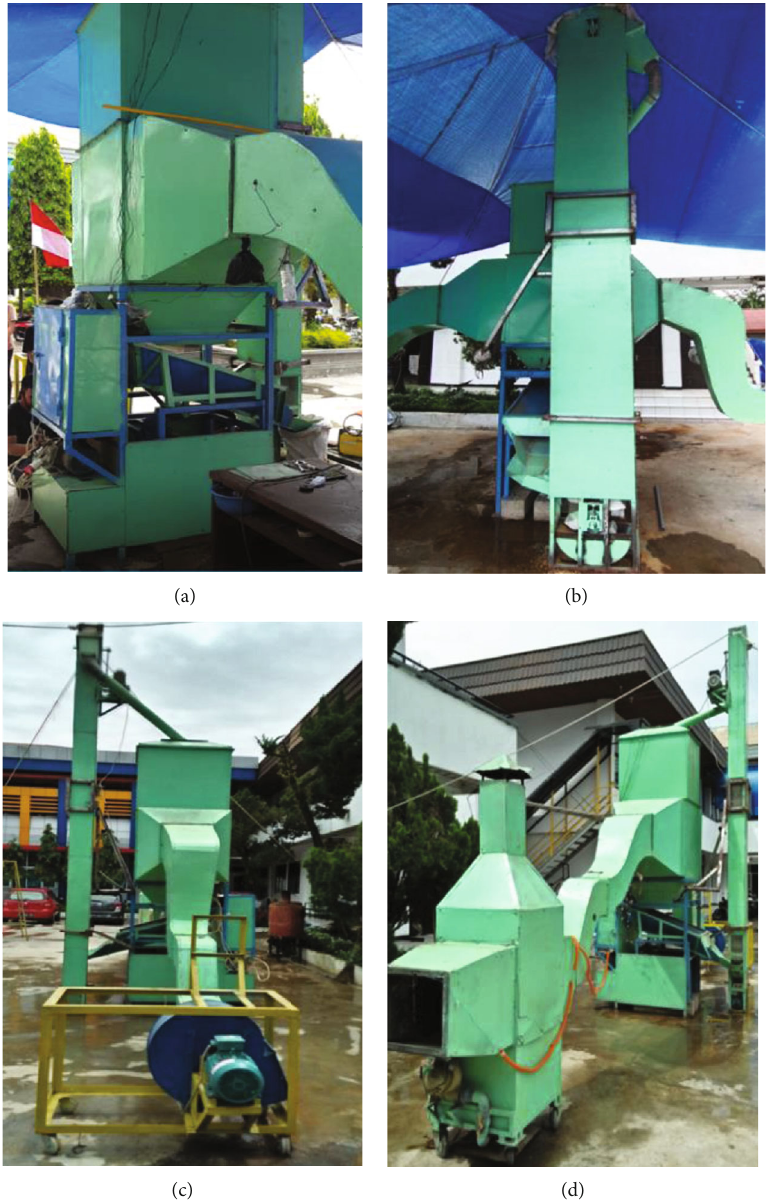
Figure 1: Photograph of the PSBA-RMFD: (a) front view, (b) back view, (c) left view, and (d) right